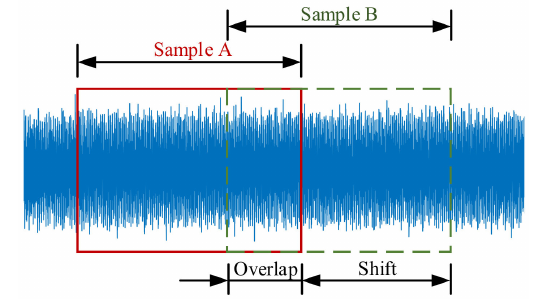
Figure 2. Overlapping sampling diagram.